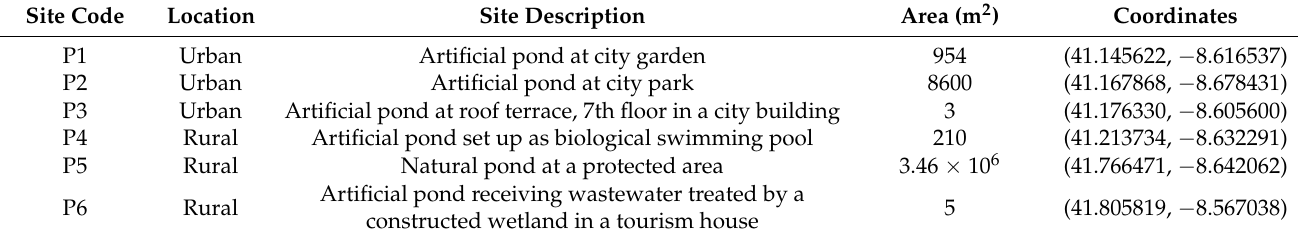
Table 1. Location and description of sampling sites.